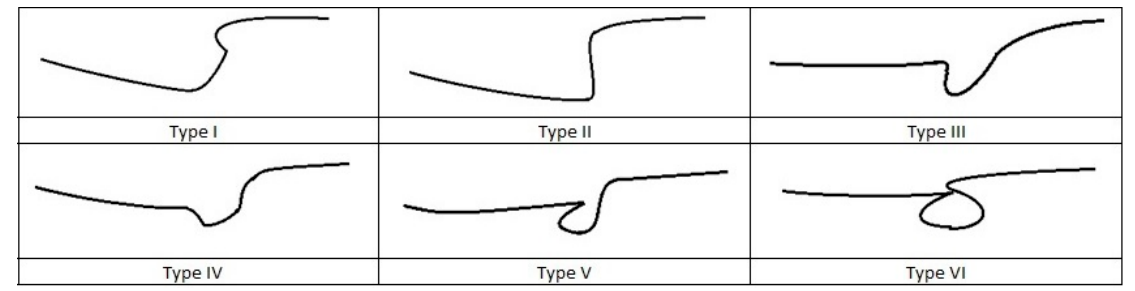
Figure 1. Rengachary morphothypes classification of the suprascapular notch.